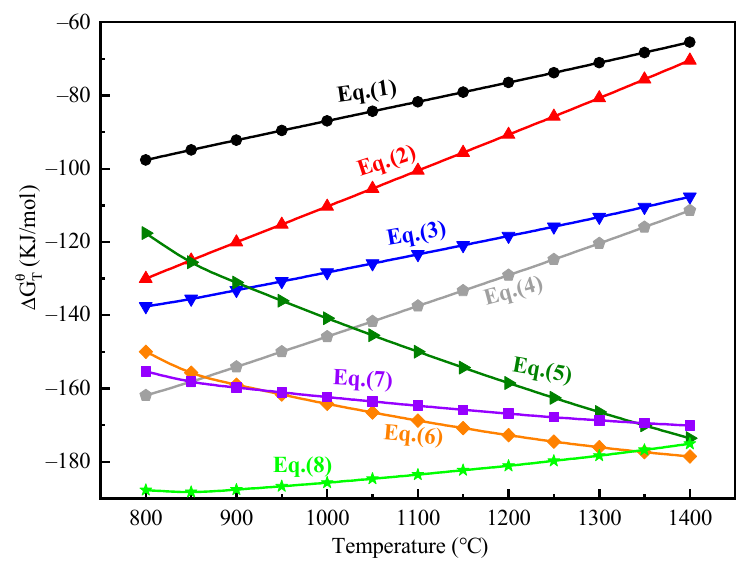
∆ G θ ) with temperature for Equations T